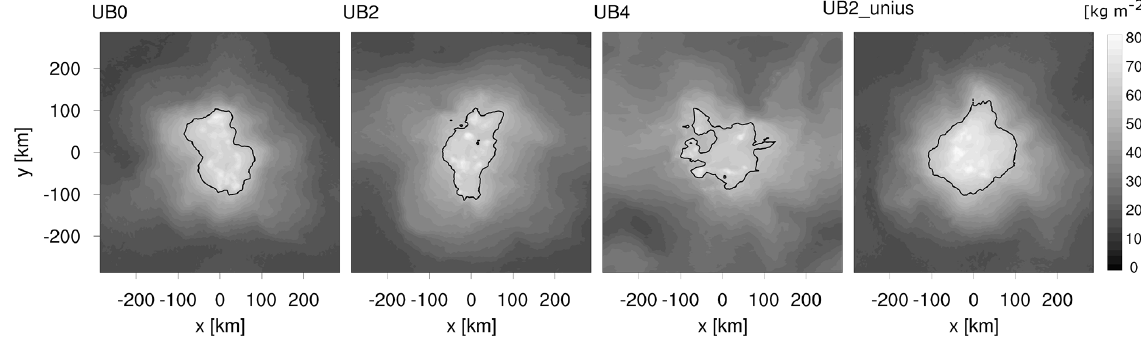
Figure 1. Daily average precipitable water on day 19. Black contours indicate where precipitable water is equal to 58kgm − 2 .